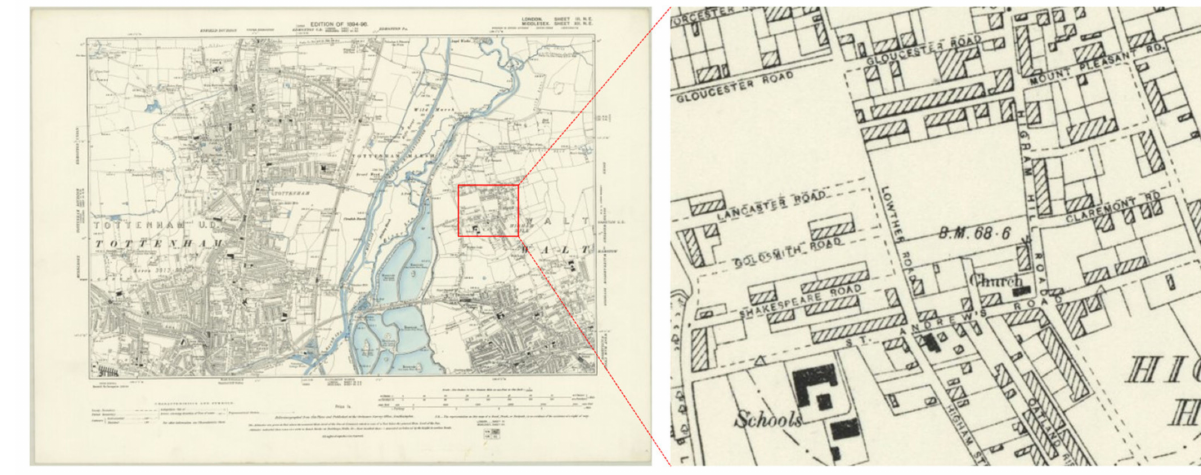
Figure 5. Raster map of northeast London published from 1894 to 1896. The map sheet size is 31 × 46 cm (ca. 12 × 18